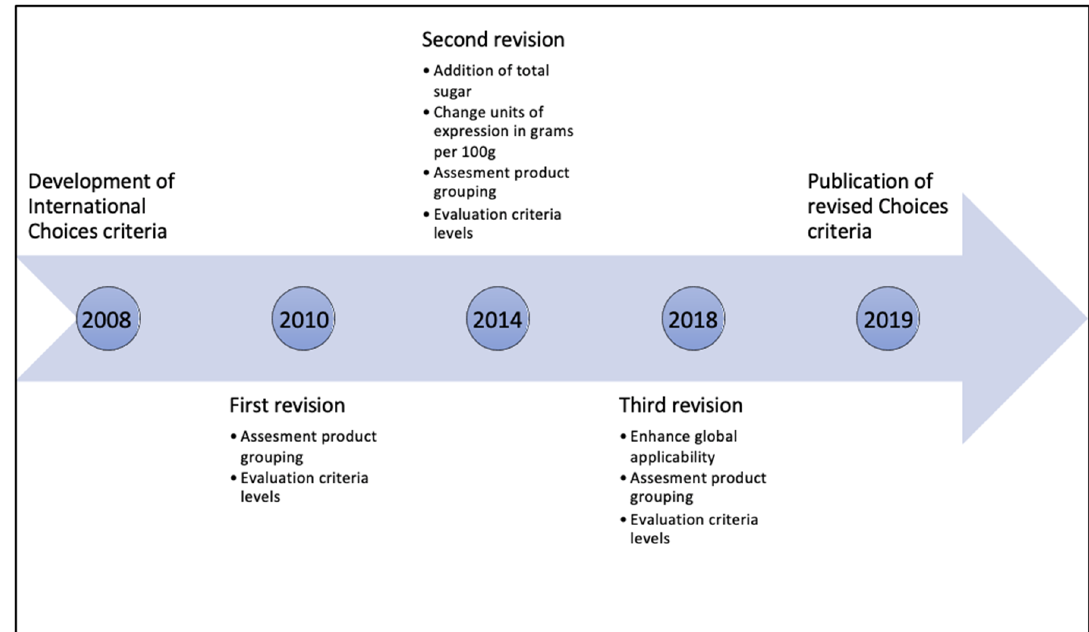
Figure 1. Timeline of the development and revisions of the International Choices criteria.